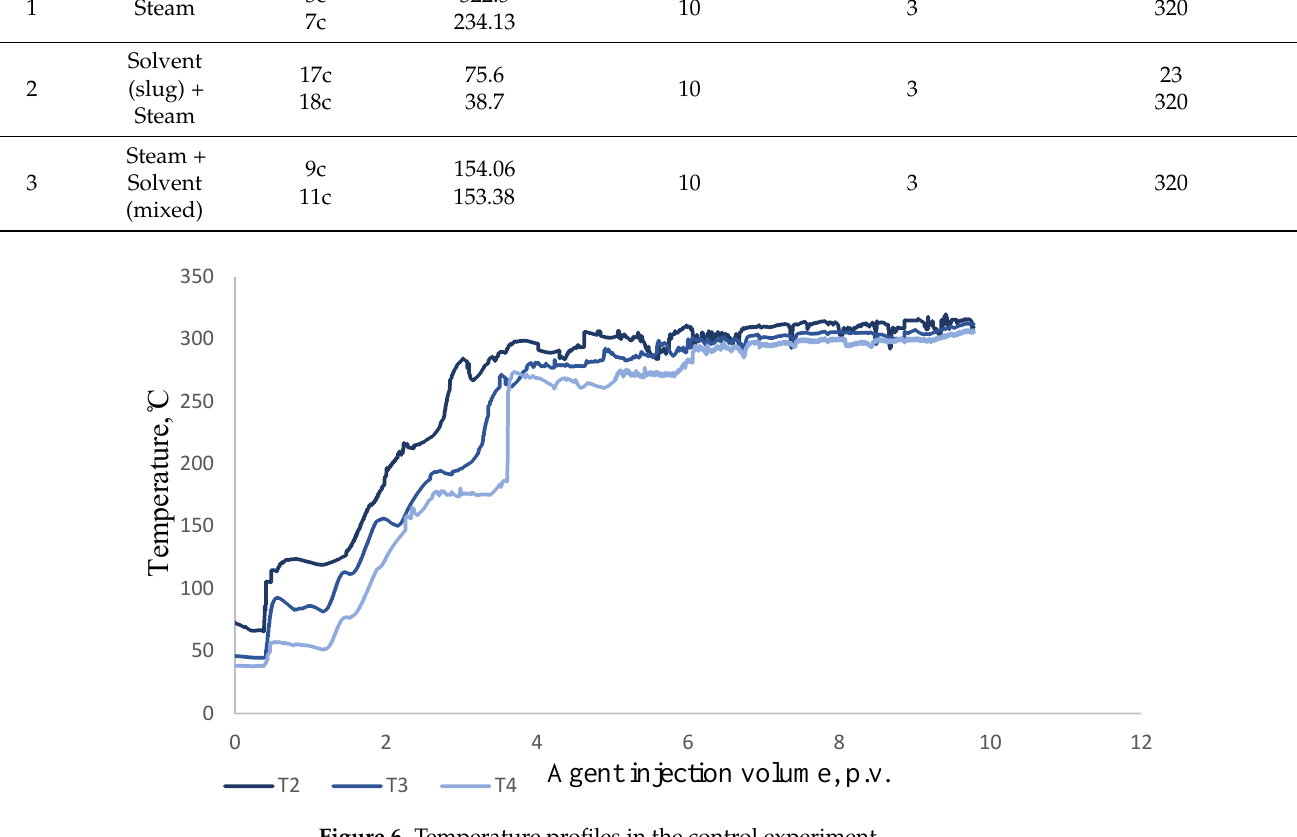
Figure 6. Temperature profiles in the control experiment. Table 12. Material balance before and after exposure in all